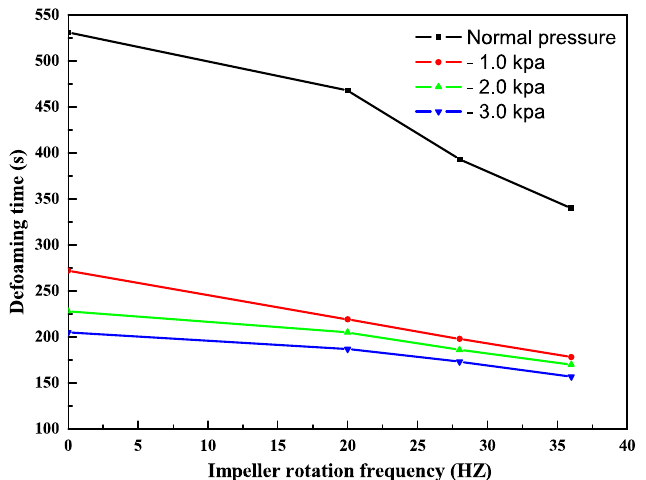
Figure 6. Relationship between impeller rotation frequency and defoaming time when using DC